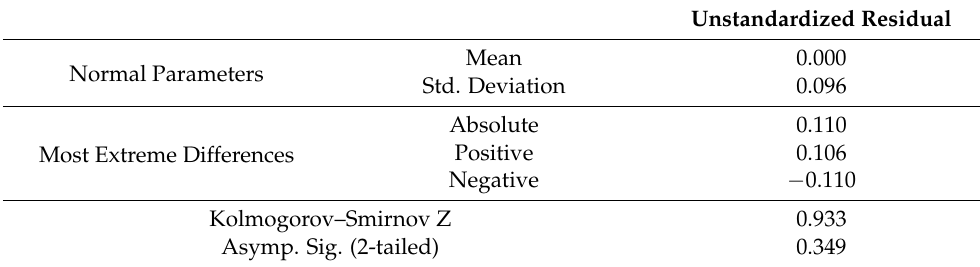
Table 4. One-Sample Kolmogorov–Smirnov Test after the COVID-19 Lockdown.